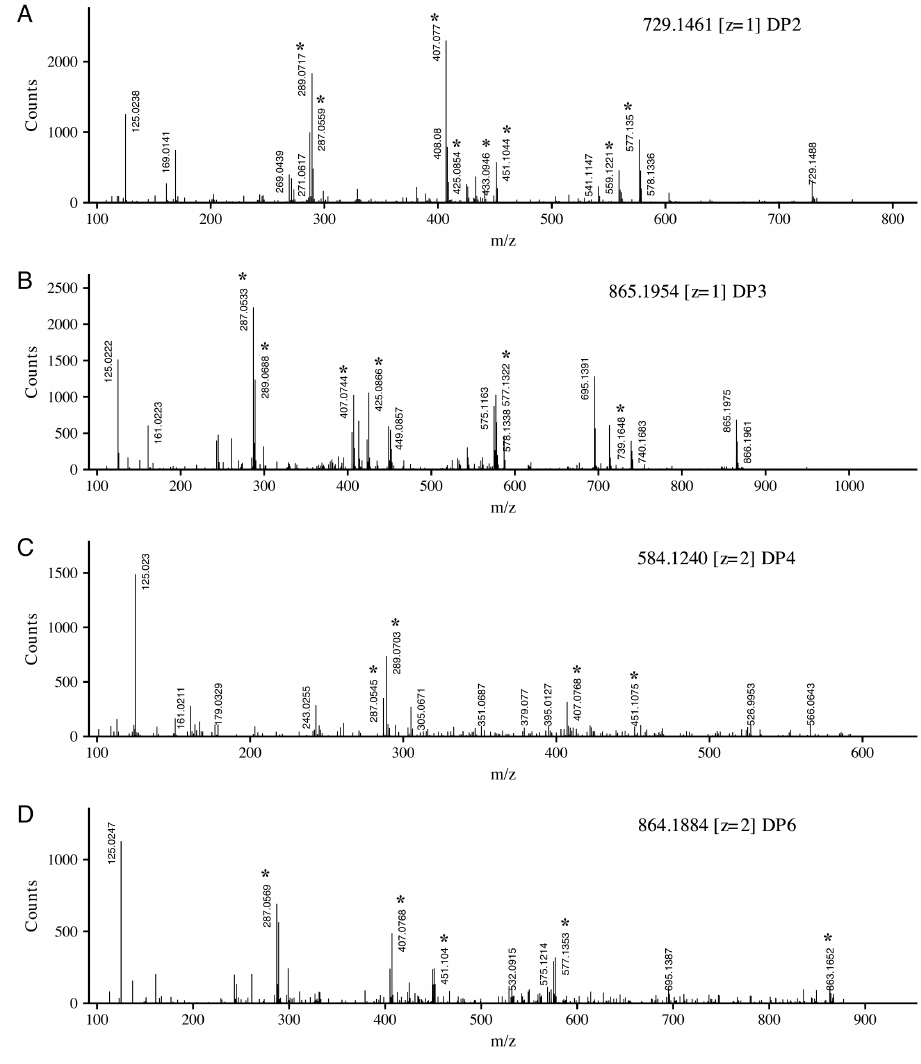
Figure 4. Negative ion electrospray ionization (ESI) tandem mass spectra of four representative proanthocyanidins. Precursor ion and charge are indicated. Diagnostic ions associated with cleavage patterns described in Figure 3 are indicated with *. Degree of polymerization (DP).